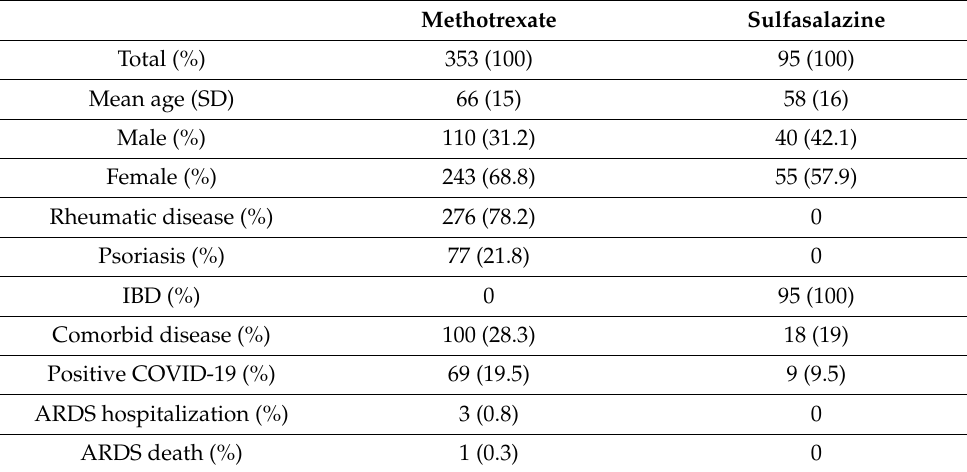
Table 3. Characteristics of patients treated with synthetic drugs.